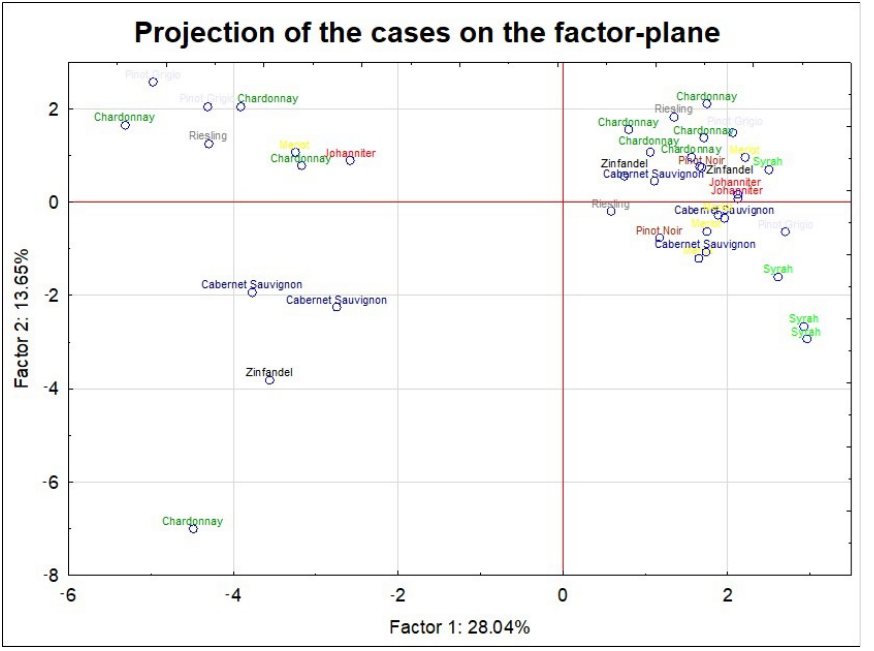
Figure 3. Projection of the cases on the factor-plane in 38 samples investigated in this study according to grape variety for the whole dataset [ µ